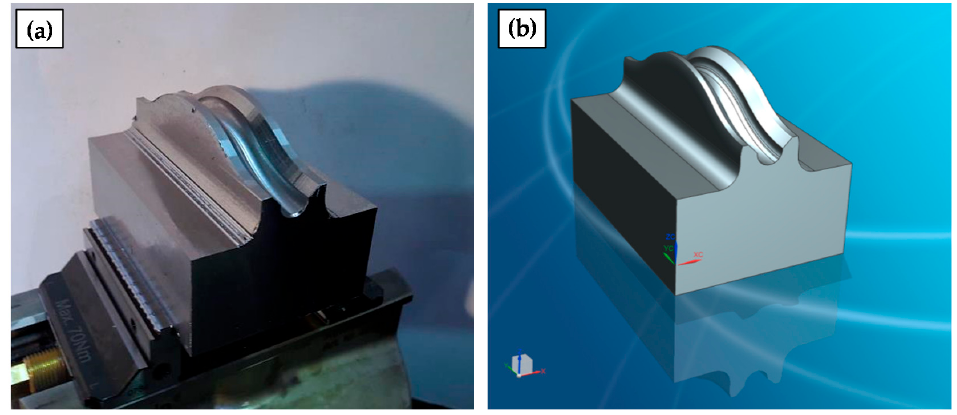
Figure 14. ( a ) Substrate before LMD; ( b ) CAD model after the preparatory machining.